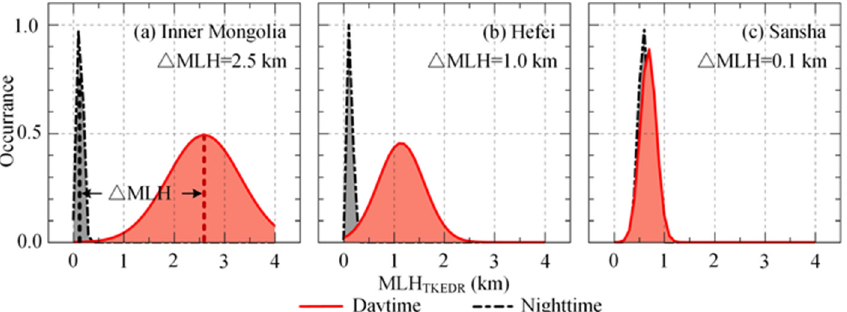
Figure 5. Statistical distributions of MLH TKEDR in daytime (red line) and nighttime (dash-dotted line) during ( a ) 21–30 September 2019 in Inner Mongolia, ( b ) 09–18 May 2019 in Hefei, and ( c ) 05–14